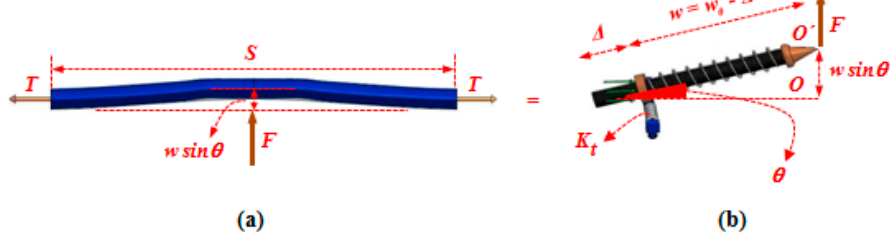
Figure 9. ( a ) Modeling of yarn as a bending beam (made of a linear, transversely isotropic, homogeneous material with an effective flexural rigidity in the longitudinal direction Q b ); ( b ) an equivalent torsional spring of coefficient K t .